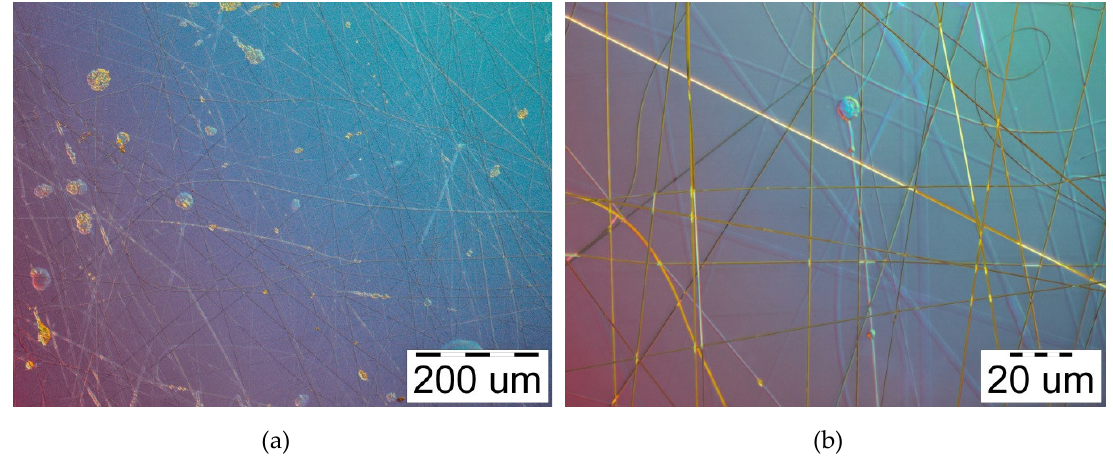
Figure 4. Microphotographs of curcumin/usnic acid-loaded hyaluronic acid fibers electrospun from the polymer solutions under 28 kV: ( a ) magnification 100×; ( b ) magnification 1000×.